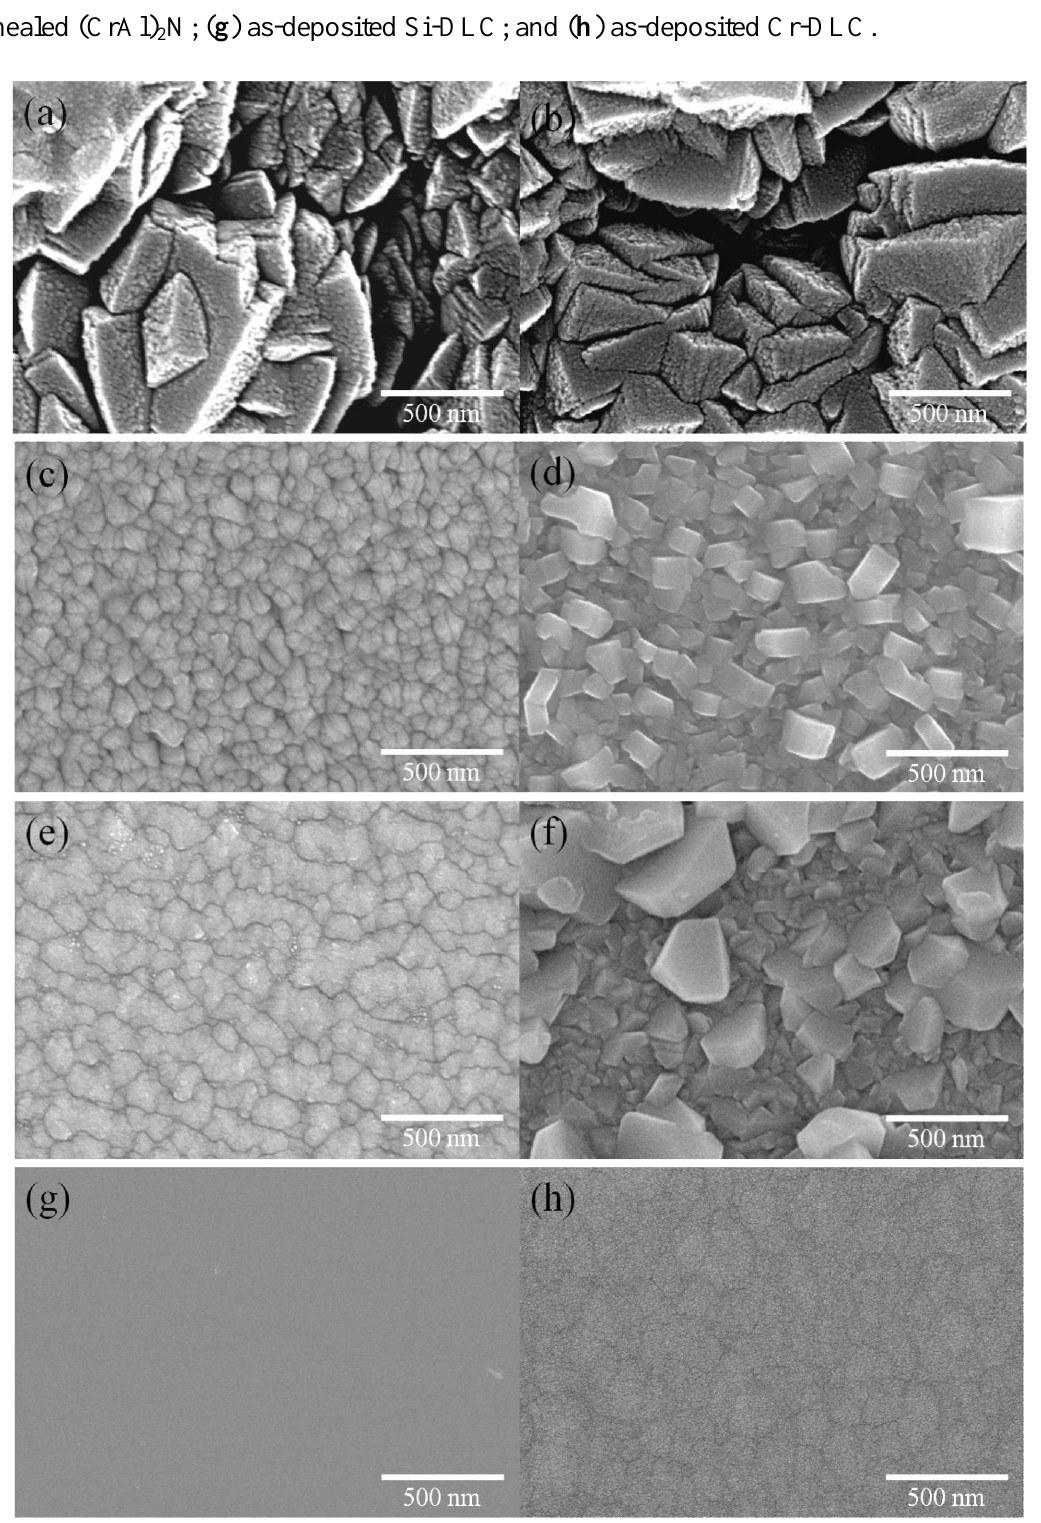
Figure 10. SEM images ( a ) as-deposited hcp-AlN; ( b ) 600 °C annealed